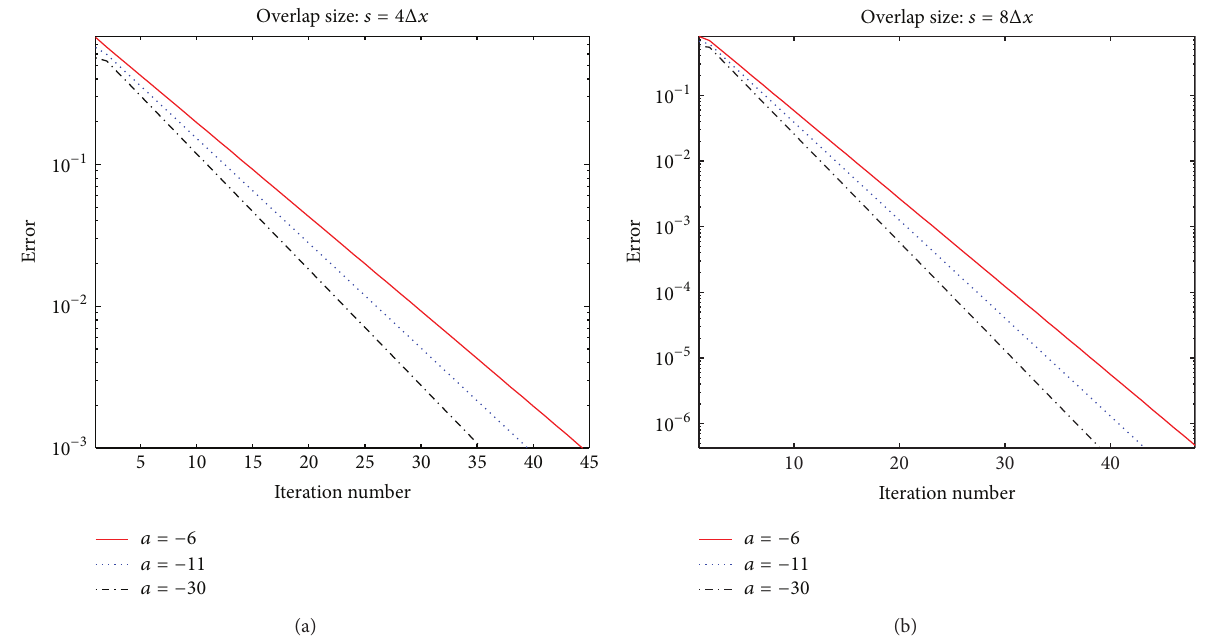
Figure 3: Influence of the problem parameter 𝑎 on the convergence rate of the SWR algorithm. (a) 𝑠 = 4Δ𝑥 ; (b) 𝑠 = 8Δ𝑥